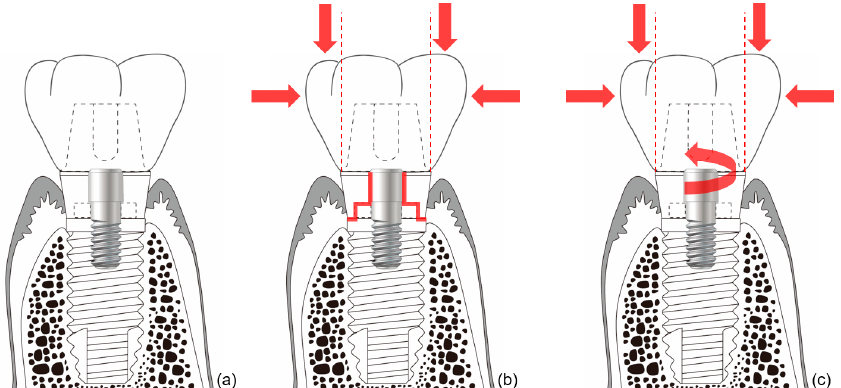
Figure 4. Schematic illustration of the ‘soft tissue seal’ theory. Micromobility of the abutment in external connection-type implants disrupts the surrounding soft tissue seal, which plays an important role in preventing external irritants from penetrating into the body. ( a ) External connection-type implant. ( b ) Parts experiencing the greatest stress (red lines) from eccentric forces (red arrows). ( c ) Abutment screw-loosening (red rotated arrow) by eccentric forces (red arrows).